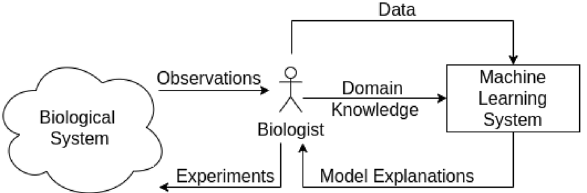
Figure 1. An example of AI for Science. The human-in-the-loop is a biologist. The biologist conducts experiments in a biological system, obtains experimental observations. The biologist then extracts data that can be used to construct machine learning model(s). Additionally, the machine learning system has access to domain knowledge that can be obtained from the biologist. The machine learning system then conveys its explanations to the biologist.